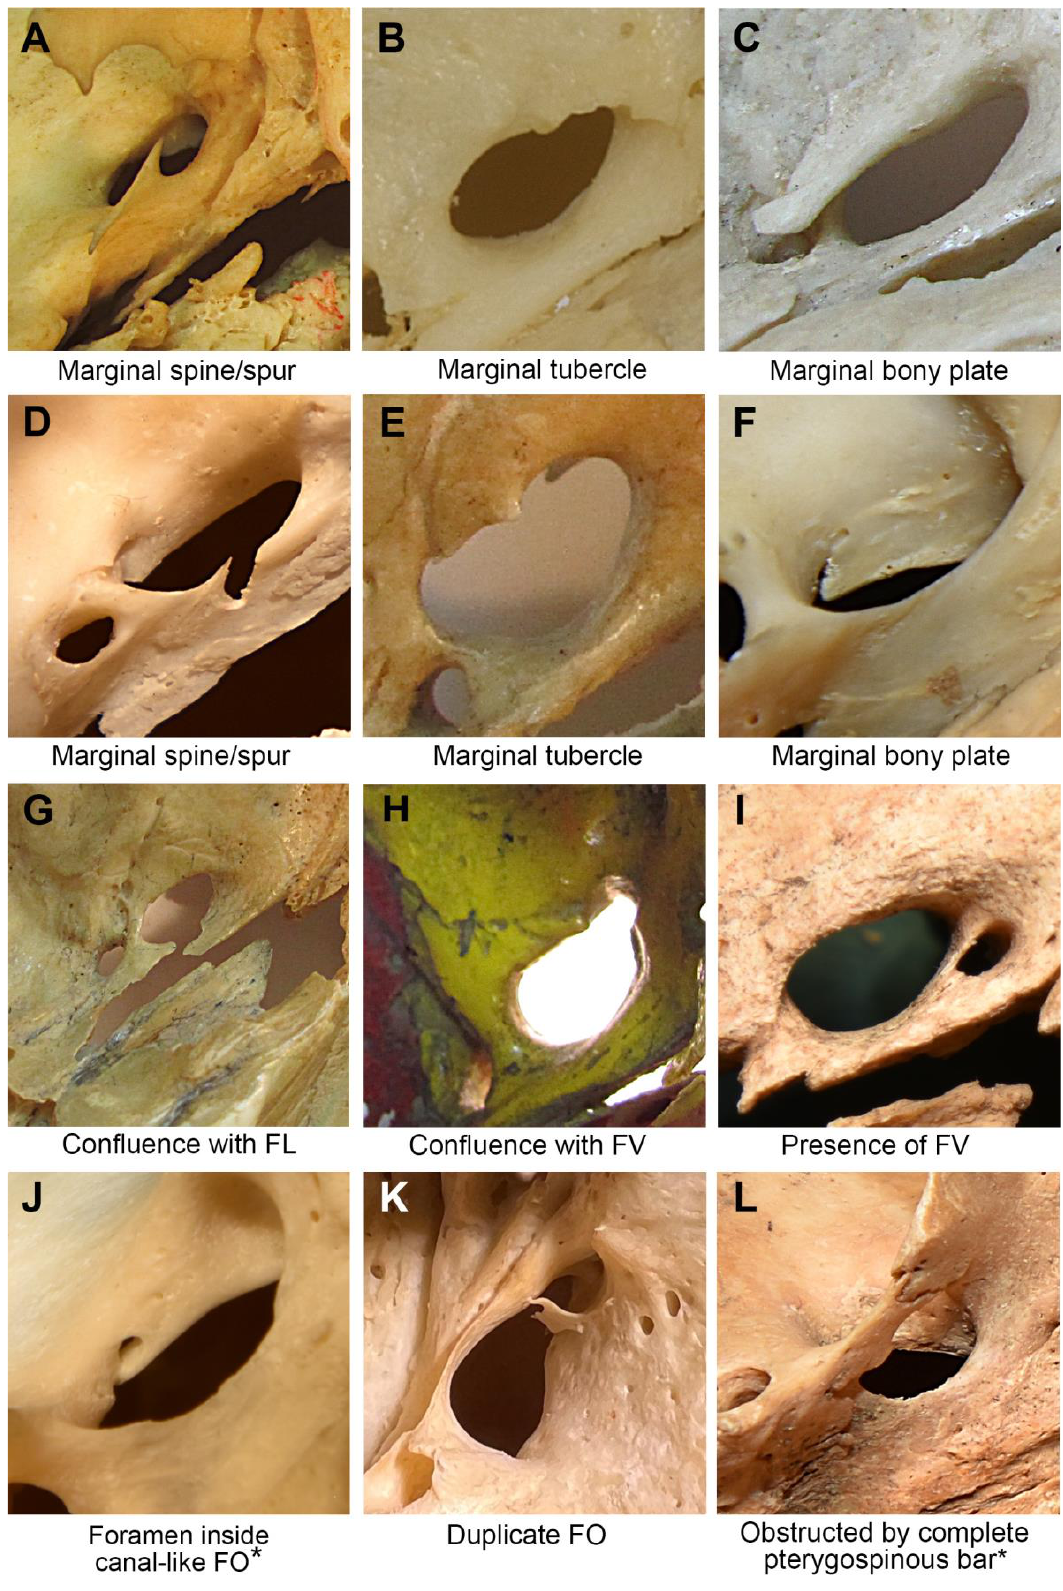
Figure 2. Foramen ovale (FO) with aberrant anatomical configurations. * Images were captured from lateral to medial direction on the external aspect of the cranial base. Images ( B , C , E , G , H , I ) were captured from the internal aspect of the cranial base. Images ( A , D , F , J , K , L ) were captured from the external aspect of the cranial base. FV — foramen of Vesalius. FL — foramen lacerum.